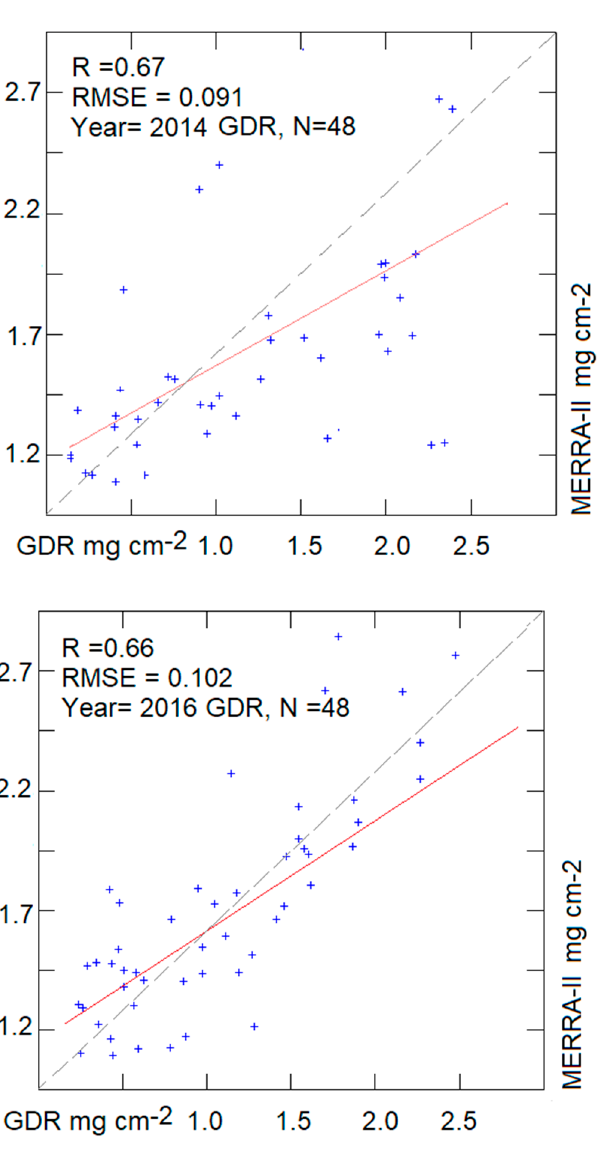
Figure 15. Relationship between MERRA-II and GDR. Plotting data correlation and Root Mean Square Error (RMSE) between annual deposition rates derived from the second modern-era retrospective analysis for research and applications (MERRA-II) and group deposition rate (GDR) data during the period 2014–2017.